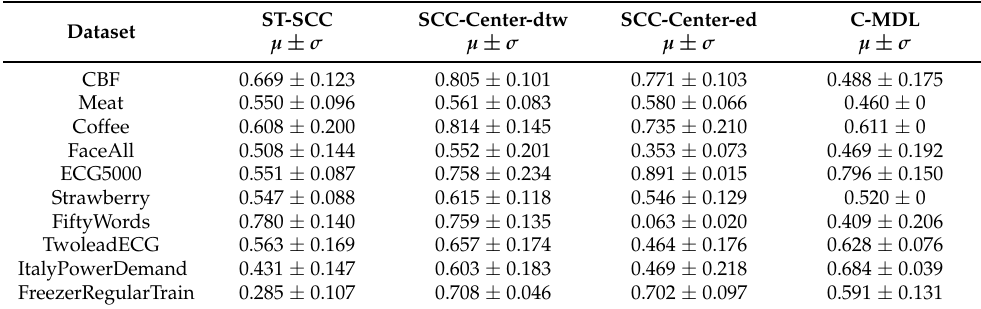
Table 2. The mean( µ ) and standard deviation( σ ) of F1 value of four methods on various datasets.